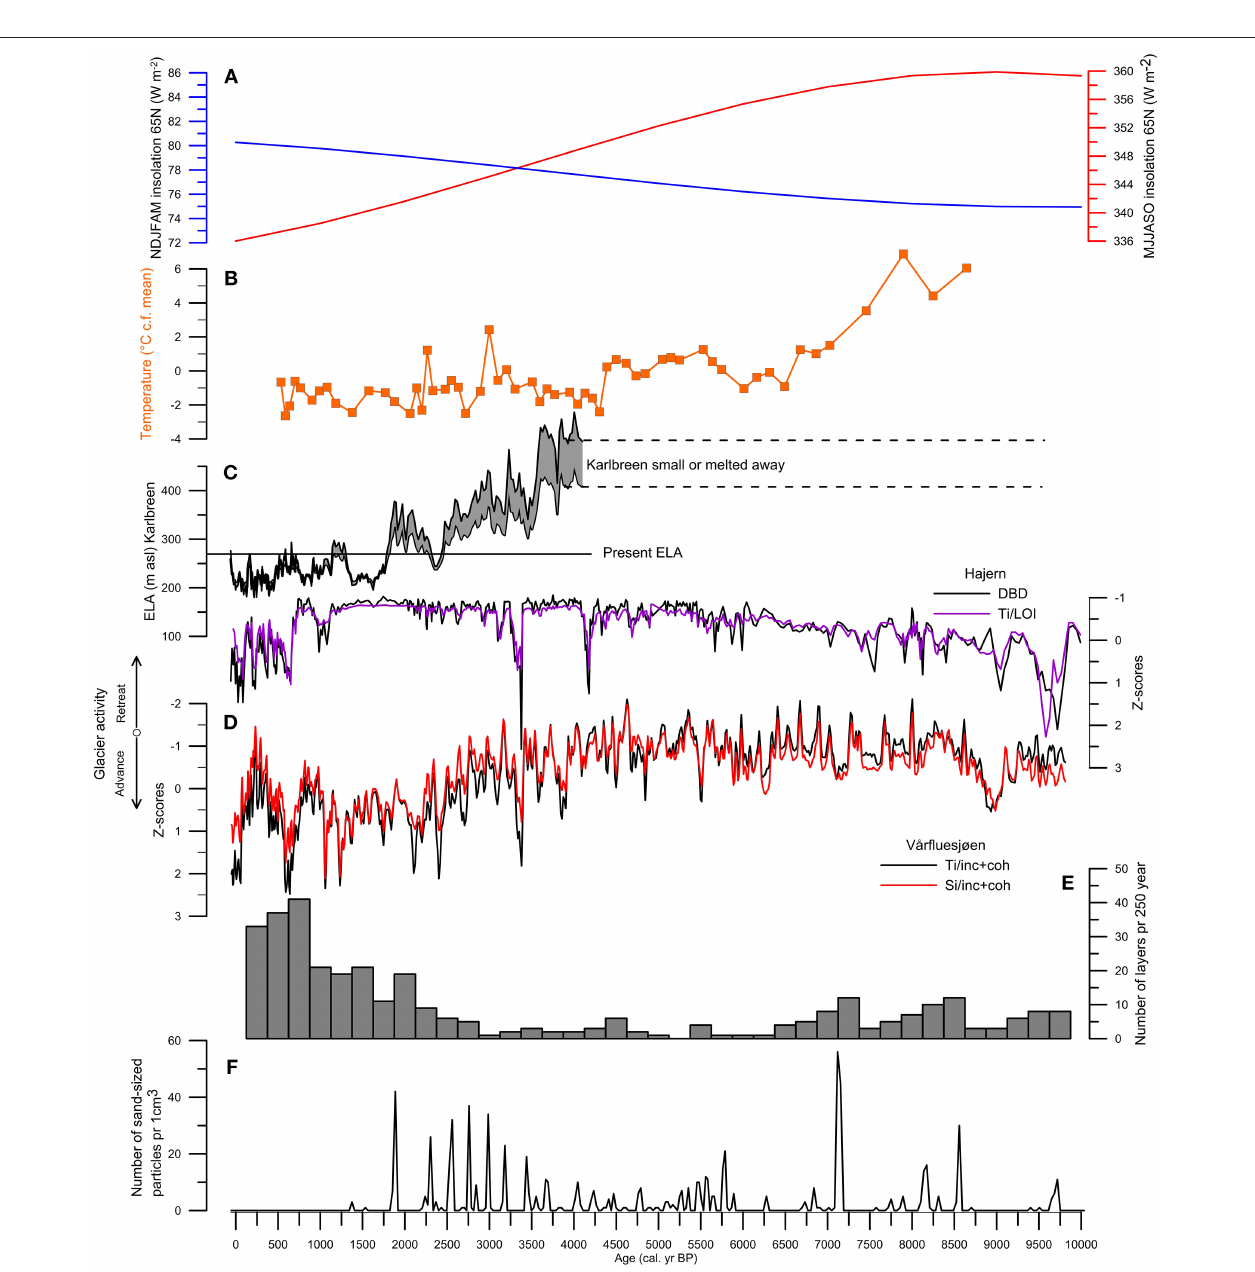
FIGURE 11 | Top part (A) Mean insolation at 65 ◦ N for the summer months [May, June, July, August, September, and October (MJJASO)] and the winter months [November, December, January, February, March, and April (NDJFMA)] from (Laskar et al., 2004). (B) Alkenone-based reconstruction of temperature based from van der Bilt et al. (2018a) (C) Reconstructed equilibrium-line altitude (ELA) for Karlbreen from Røthe et al. (2015). (D) The standardized Ti/LOI and DBD values from the record of van der Bilt et al. (2015), at Hajern (Mitrahalvøya), is plotted using purple and black lines, respectively. Red and black line indicates the relative glacier variability upstream from Vårfluesjøen (this study) using standardized Ti/inc + coh and Si/inc + coh values with a 24-point running average (0.5cm resolution). (E) Number of snowmelt layers recorded in Vårfluesjøen (this study) is shown using a bin size of 250 yr. (F) The frequency of sand-size particles (larger than 255 µ m) identified and counted using the X-ray CT is shown against age (cal. yr. BP) for every 1 cm 3